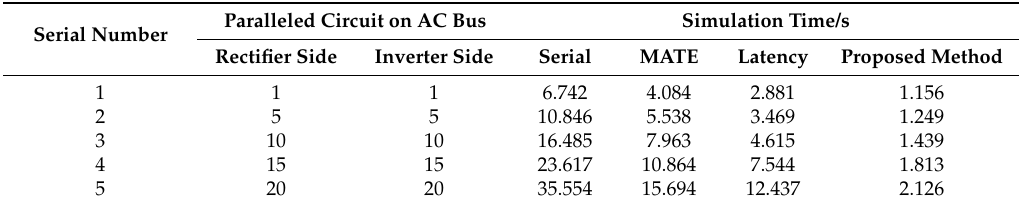
Table 3. Setting of simulation step.